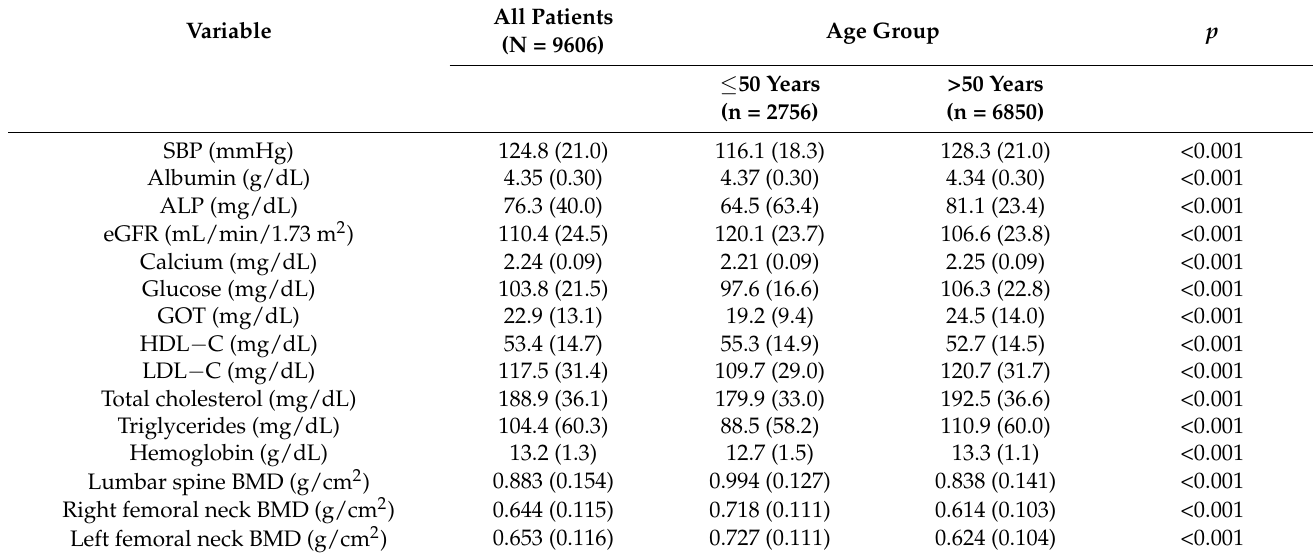
Table 2. Laboratory measurements of the patients (N =